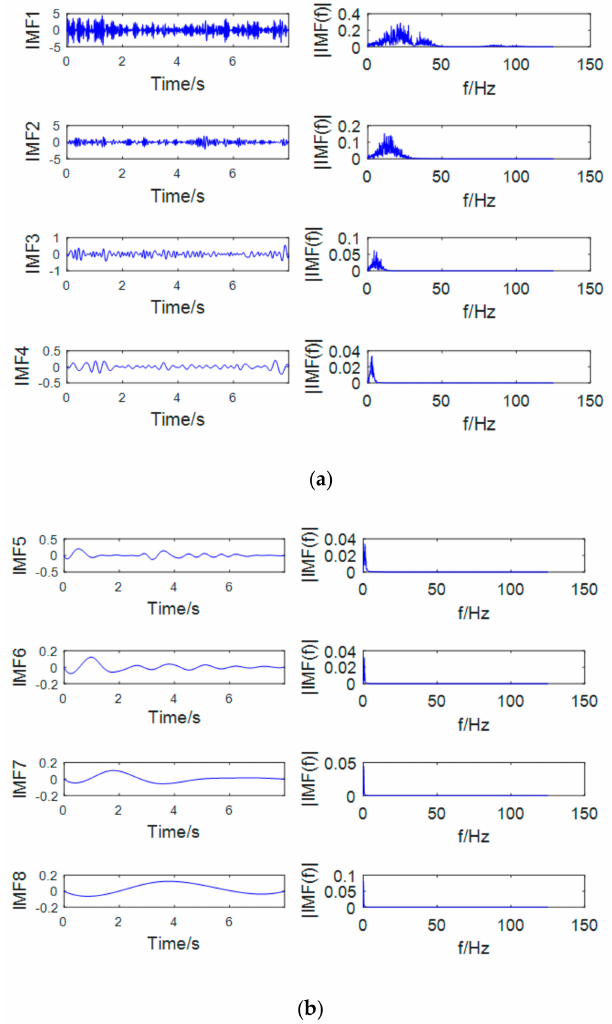
Figure 7. Sub-band D3 empirical mode decomposition (EMD) graph (left—waveform, right—spectrum): ( a ) IMFs and corresponding spectrum of orders of 1-4 by EMD method. ( b ) IMFs and corresponding spectrum of orders of 5-8 by EMD